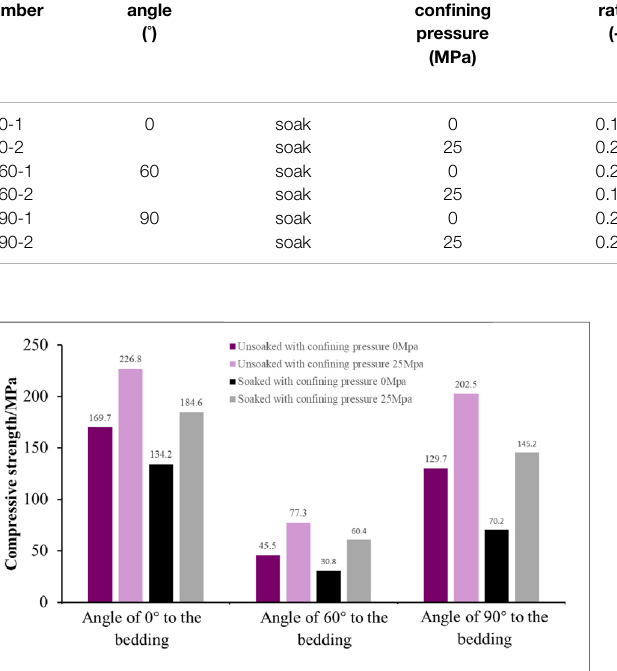
FIGURE 4 | Comparison of compressive strength before and after drilling fl uid